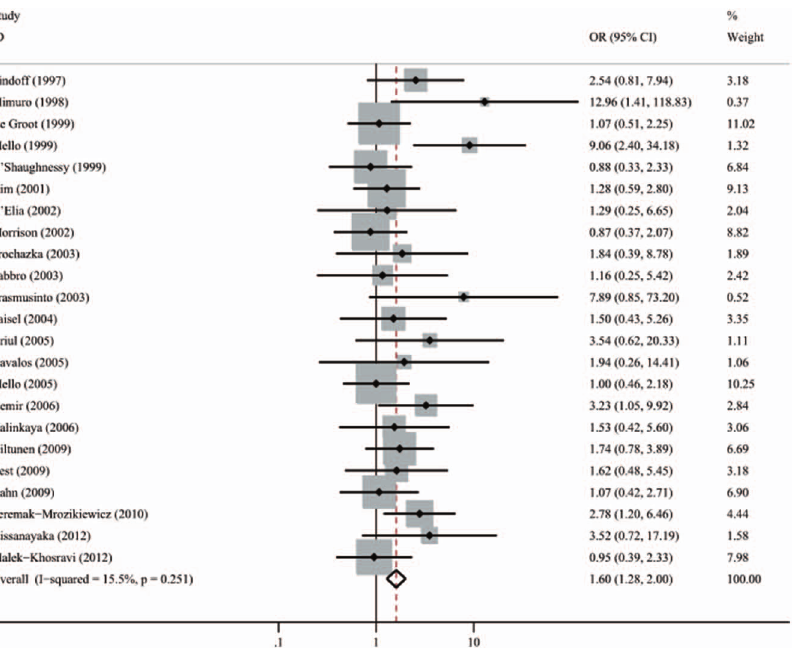
Figure 6. Forest plots of OR with 95%CI of all preeclampsia associated with FVL in fixed model. Black square means value of OR, and the size of the square means inversely proportional to its variance. Horizontal line means 95% confience interval (CI) of OR. Black diamond means pooled result.